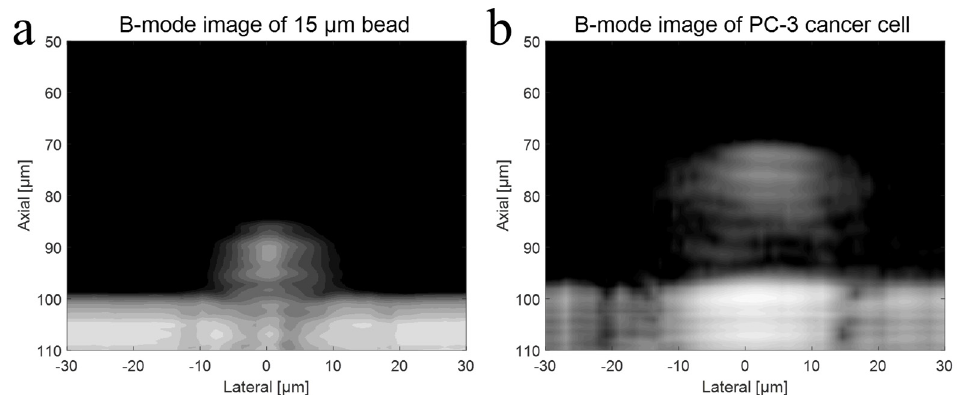
Figure 7. ( a ) Raw signal from the center with and without ( w/o ) a PC-3 cell with a 110 MHz transducer, and ( b ) signal after Hilbert transform from the center with and w/o a PC-3 cell with a 110 MHz transducer.